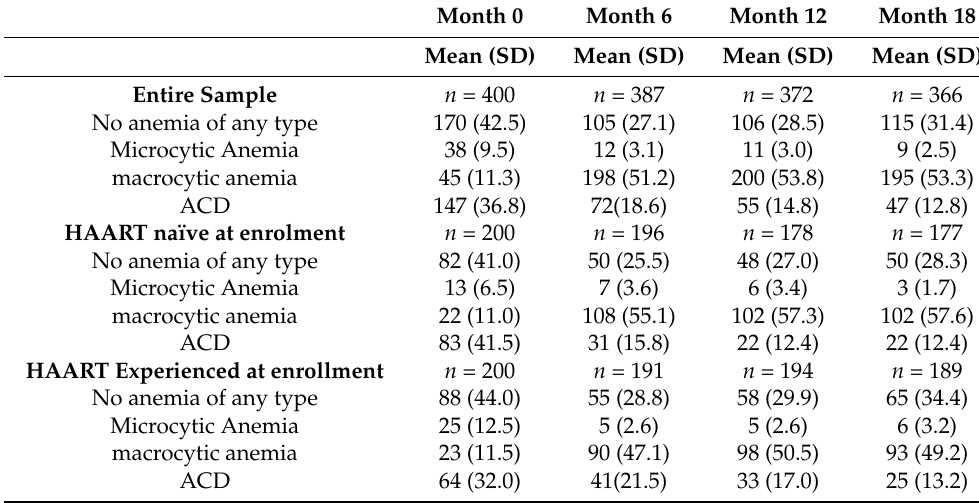
Table 2. The temporal trends in the change of the Anemia type over the 12-month Follow-up: Entire Sample and by Baseline HAART